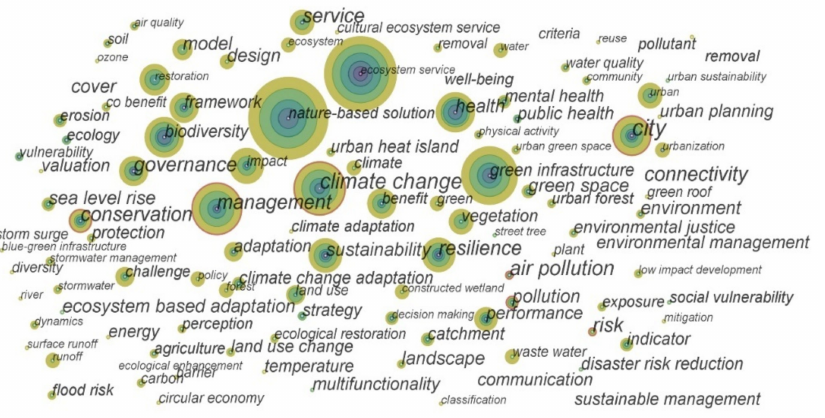
Figure 3. Major keywords of nature-based solution research. The size of the node represents the frequency of keyword